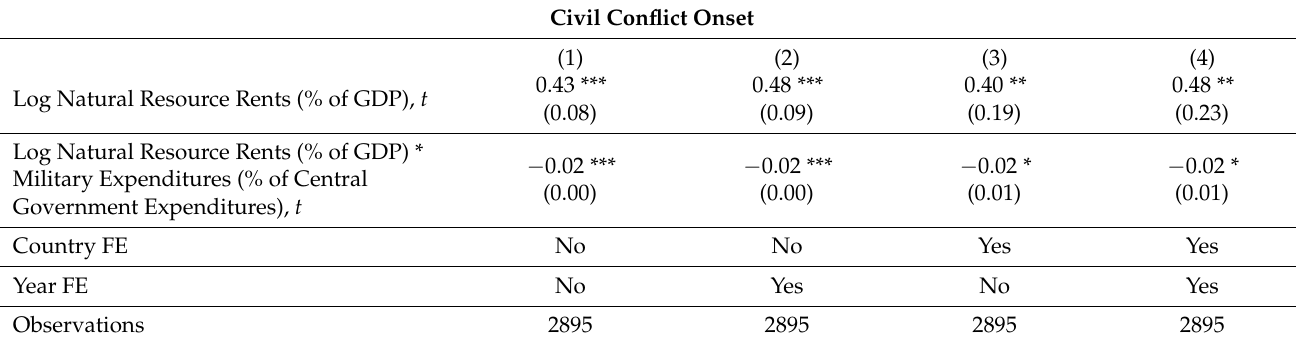
Table 5. Robustness: Military Expenditures as a Share of Central Government Expenditures Time-Varying. Civil Conflict Onset